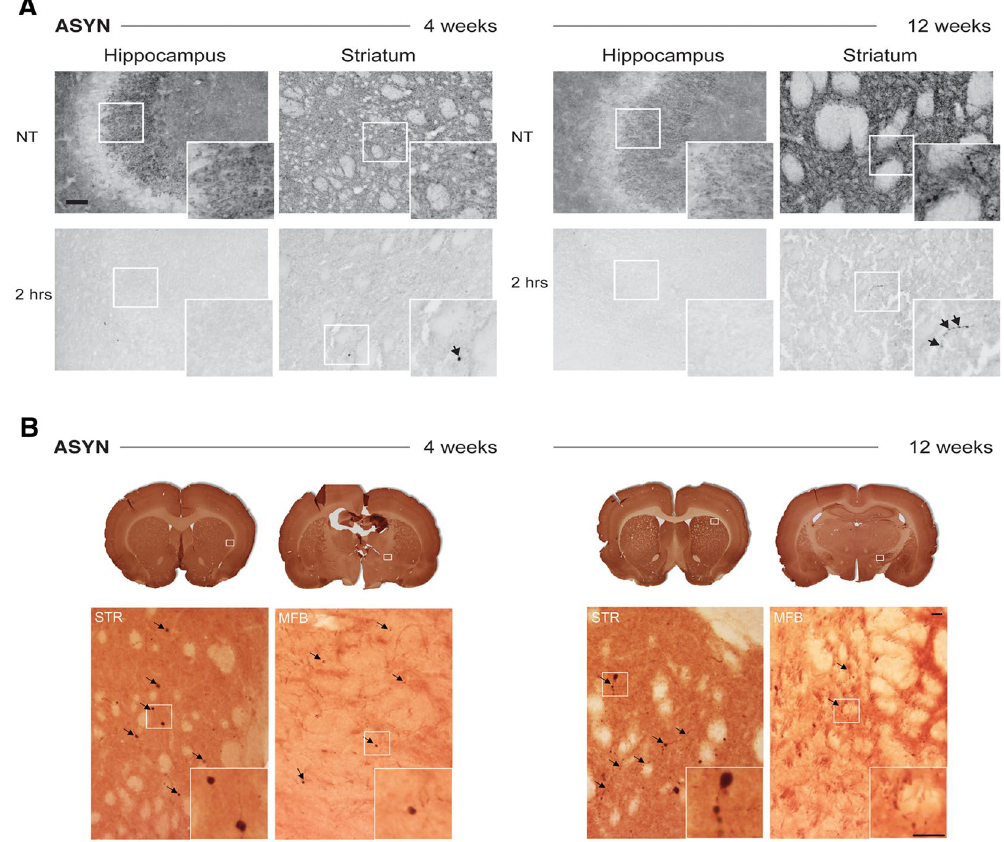
Figure 8. Pathological α -synuclein is present in axonal swellings. ( A ) The effect of proteinase K treatment on the hippocampus and striatum from ASYN animals at 4 and 12 weeks post-surgery. Sections were incubated with KPBS (NT; top row) or Proteinase-K in KBPS for 2 hours (2 hrs; bottom row), and then immunostained with an antibody recognizing both human and rat ASYN; inserts display higher magnifications of details framed in the photos. The hippocampus showed abundant endogenous ASYN + signal in the CA3 that disappeared after 2 hours of proteinase K treatment. However, proteinase-K-resistant ASYN + aggregates (arrows) were found in striatum from animals at 4 and 12 weeks. At 4 weeks, the proteinase-K resistant formations appeared as round scattered formations in ASYN animals (arrow in inset). After 12 weeks, we observed thick fibers and rosary-like ASYN + formations, which were resistant to proteinase K digestion (arrows in inset). Scale bar = 60 µ m applies to all. ( B ) P-Ser129-ASYN immunostained frontal and caudal striatal sections from ASYN animals 4 weeks (left), and 12 weeks (right) post-surgery. For each section showed in low power (top row) a high power image is presented in the bottom row to reveal details of the immunostaining in the striatum and medial forebrain bundle (MFB). In addition, each inset shows details of the P-Ser129-ASYN + structures shown in the high power photos. While at 4 weeks, single round P-Ser129-ASYN + inclusions were found in thin fibers (arrows and inset) in striatum, at 12 weeks we could find several of those round inclusions per fiber, which appeared as a rosary- like structures (arrows and inset). We also observed immunostaining in the MFB, with some single round inclusions at 4 weeks, that were smaller but more numerous at 12 weeks. Scale bar = 20 µ